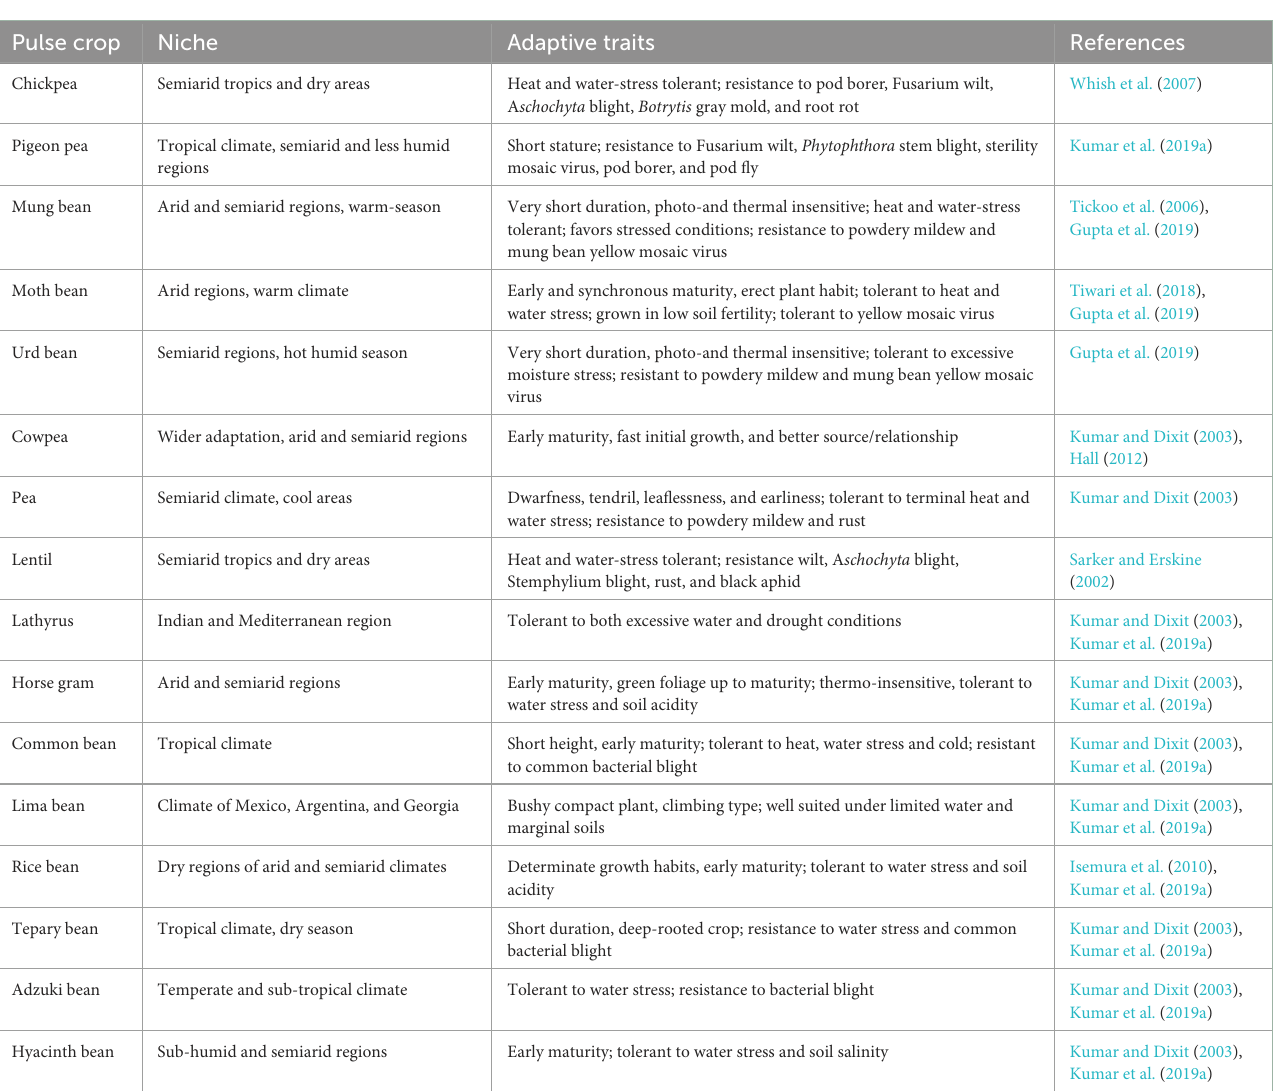
TABLE 9 Adaptive traits of pulse crops to climate extremes. Pulse